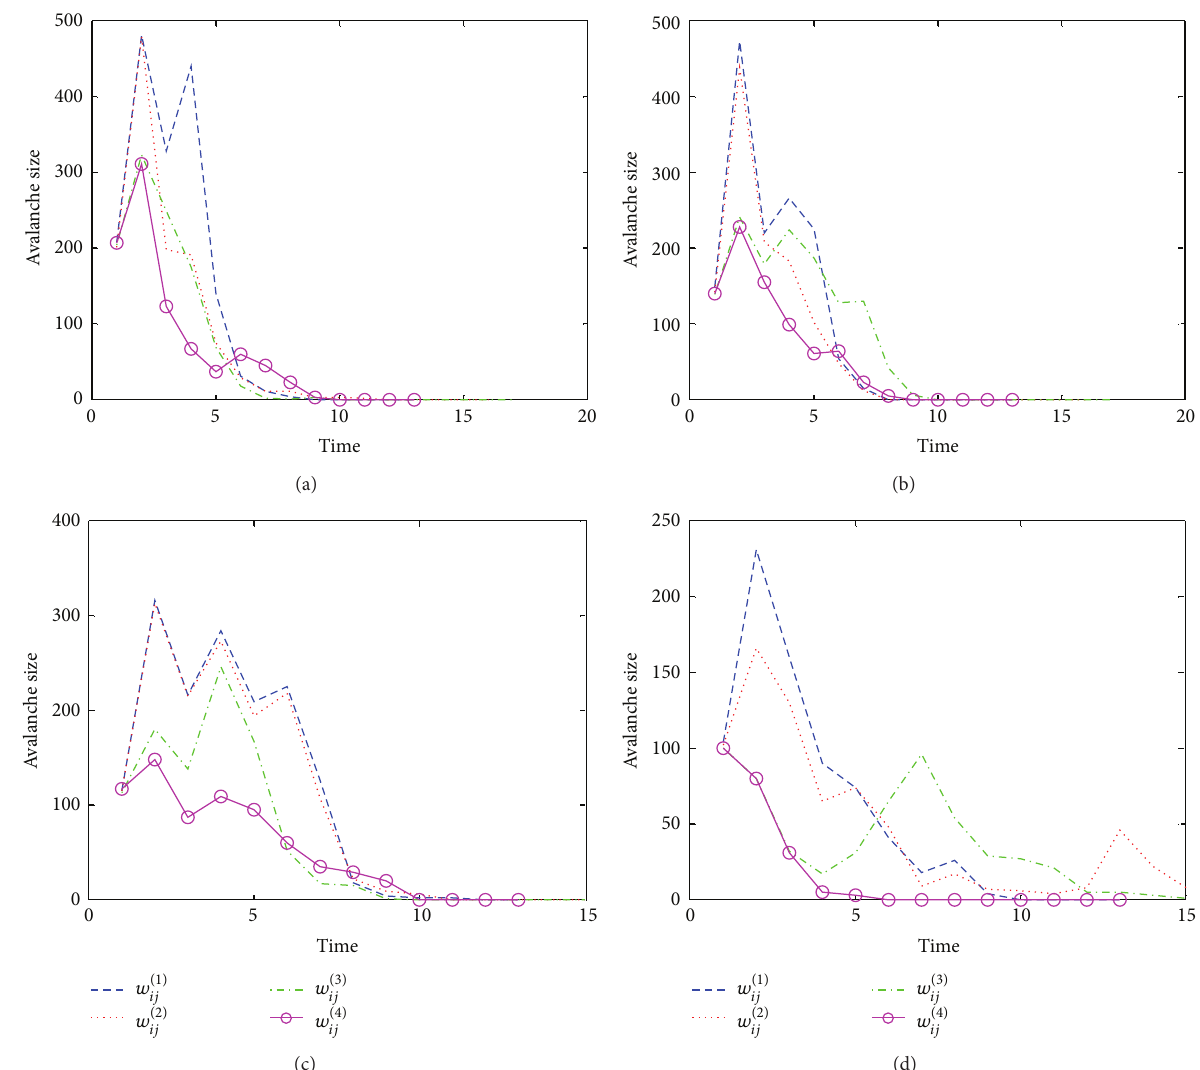
(𝑡) in each time step 𝑡 as a function of 𝑡 for ae